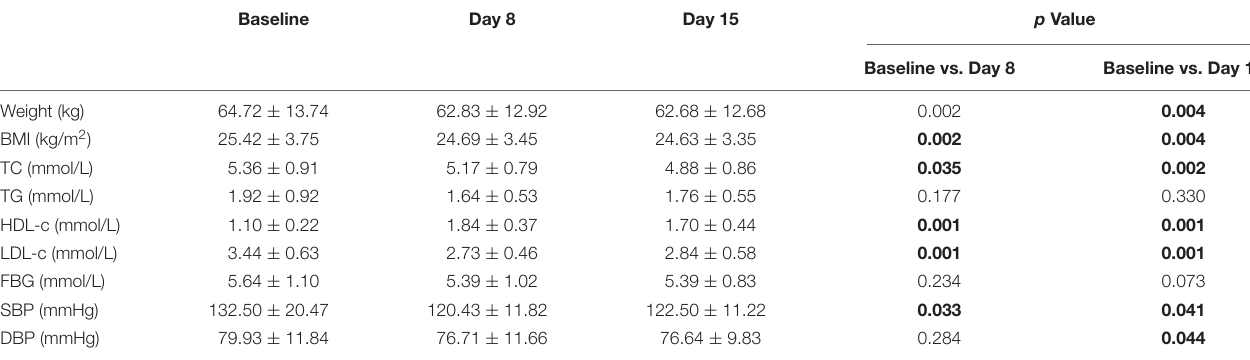
TABLE 1 | Body composition and biochemical parameters of participants throughout the study a .